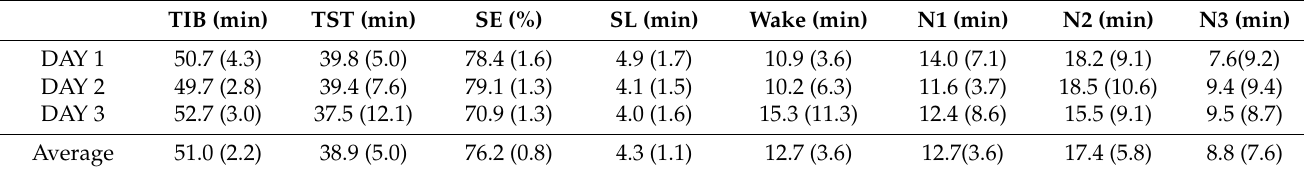
Table 1. Sleep parameters during napping on each experimental day.